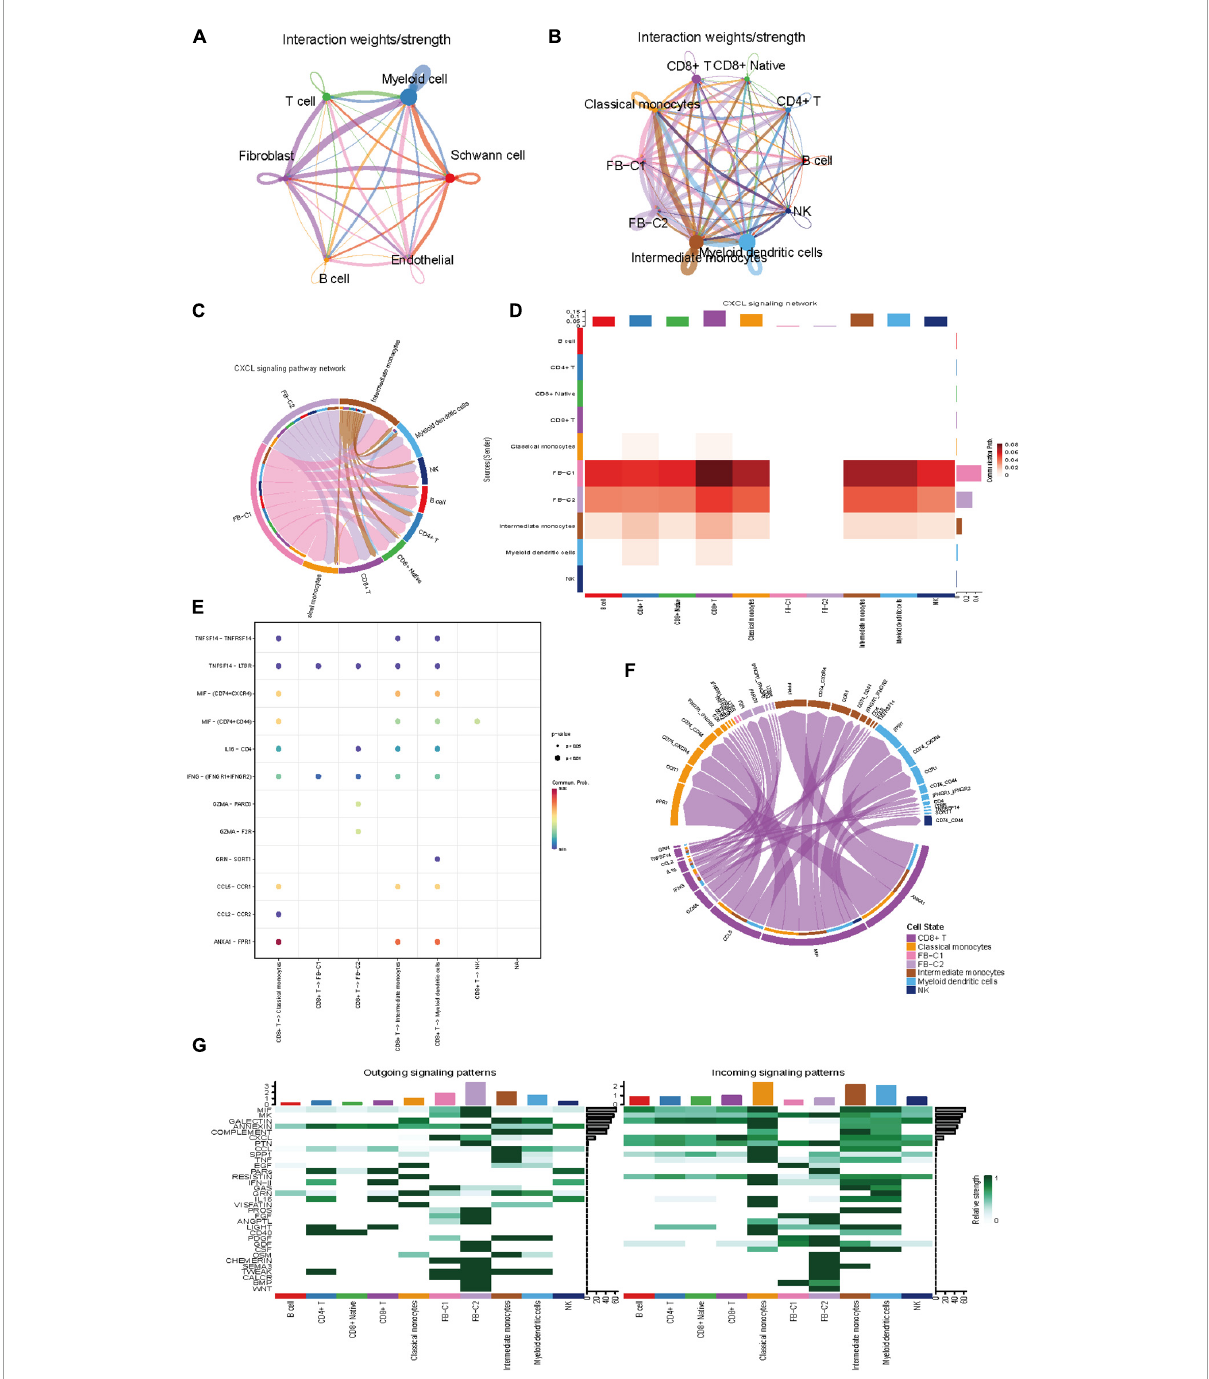
FIGURE4 Intercellular communication between cell subset in VS. (A) Circle plot showing the intercellular communication between major VS cell types, using Cellchat workflow. The lines originating from a cell type indicate ligands being broadcast, with these lines connecting to the cell type where the receptors are expressed. The thickness of the line is proportional to the number of unique ligand-receptor interactions, with loops representing autocrine circuits. (B) The network between Subpopulations of T cells, B cells, myeloid cells and fibroblasts. (C) The CXCL signaling pathway network. (D) Heatmap of differential interactions between Subpopulations of T cells, B cells, myeloid cells and fibroblasts in the cell-cell communication network of the CXCL signal pathway. The top-colored bar plot indicates the sum of column values (incoming signaling), and the right bar plot indicates the sum of row values (outgoing signaling). Red indicates increased signaling in CXCL pathway, and blue indicates decreased signaling. (E) The CXCL signaling pathway ligand receptor bubble plot. (F) Communication string diagram of cell subsets. (G) Signaling role analysis on the cell-cell communication networks of